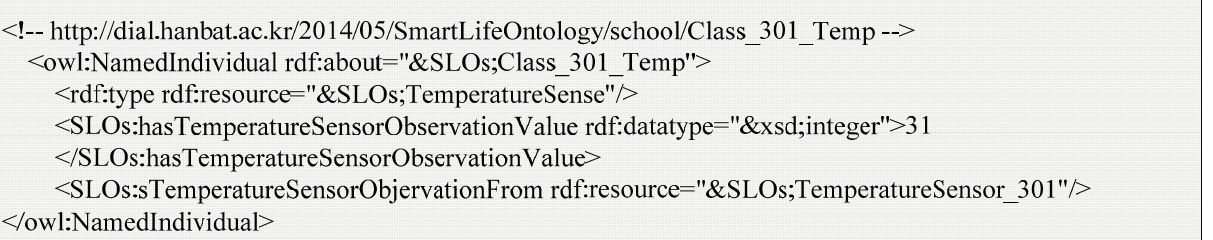
Figure 9. OWL description of Class_301_Temp context.